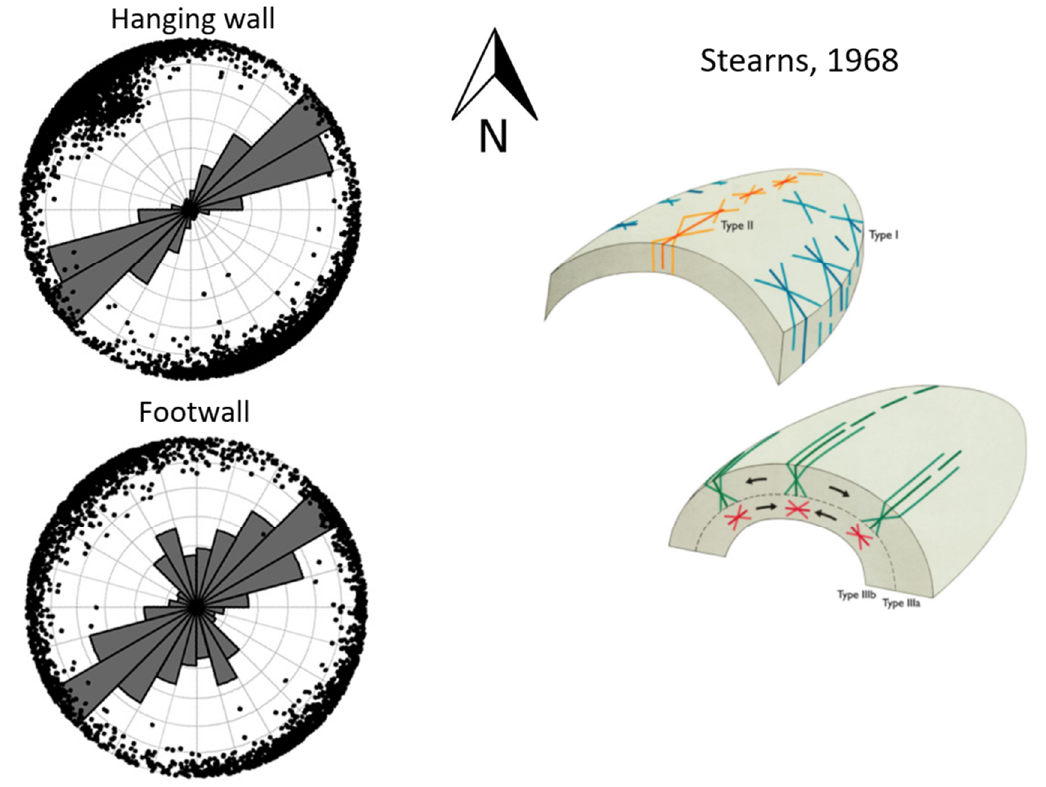
Figure 11. Rose diagrams (left) show the dip azimuths (dots) and strike azimuths (rose petals) for fractures in the Cusiana fault hanging wall and footwall. Schematic diagrams (right) show fracture types associated with folding (Stearns, 1968).